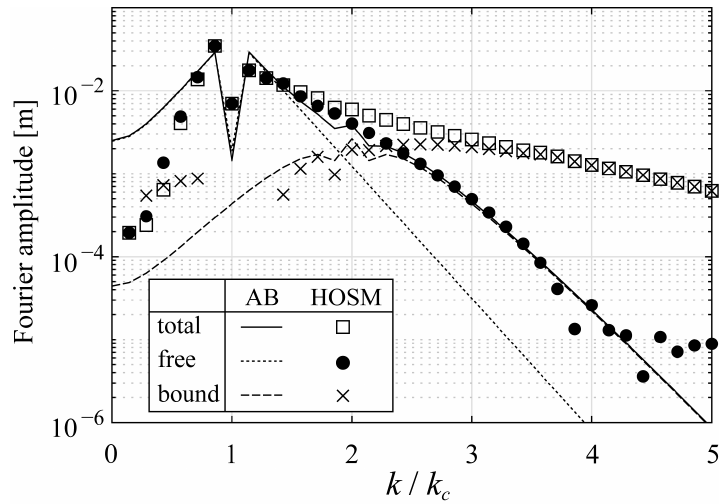
Figure 8. Comparison of the Fourier amplitudes of the modulated wave trains with a 0 k c = 0.105 in the wavenumber domain at the time of the maximum crest height in the HOSM simulation and AB solution. Note that the bound-wave spectrum of the HOSM simulation breaks around k / k c because its spectral energy is removed owing to the ideal filter separating free and bound waves.